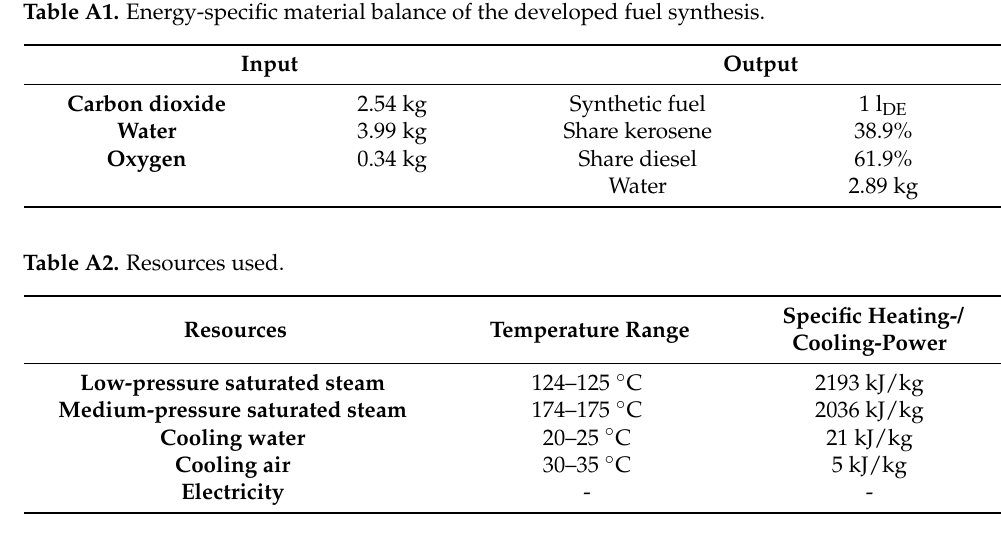
Table A3. Energy-specific resource balance of the developed fuel synthesis. Negative values in the sum mean that excess steam is available from the process. See Table A2 for details on the resources used.